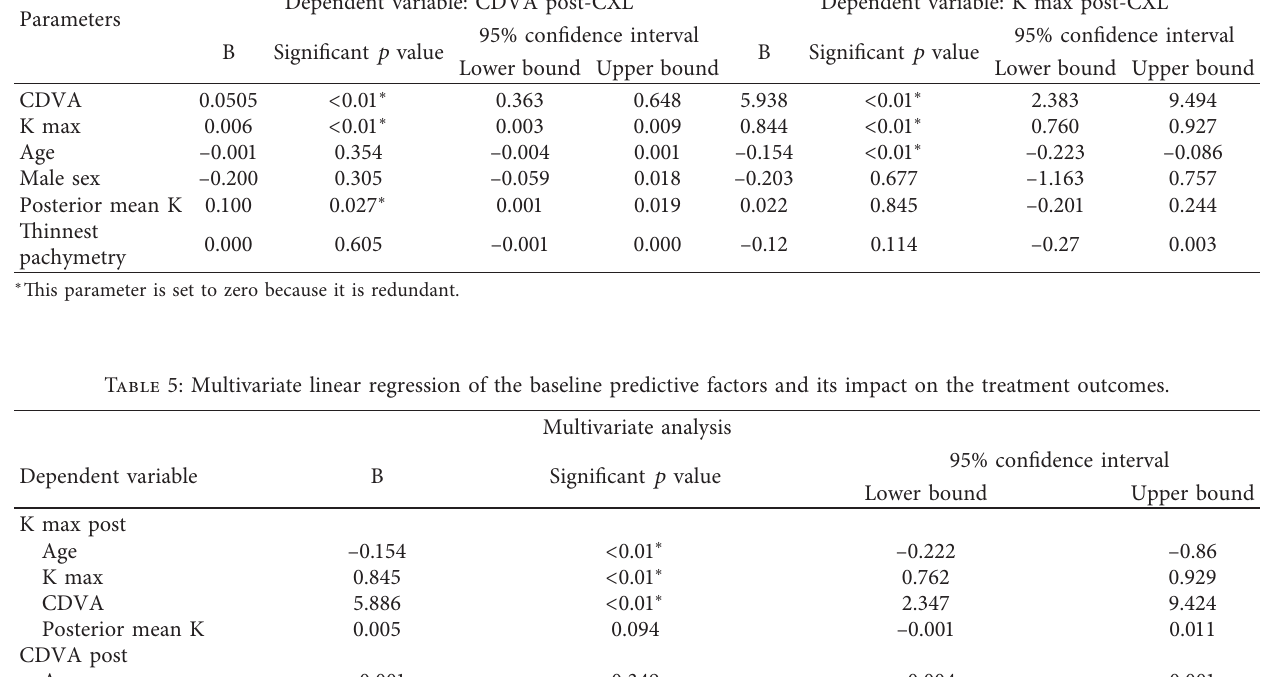
Table 4: Univariate linear regression of the baseline predictive factors and its impact on the treatment outcome.